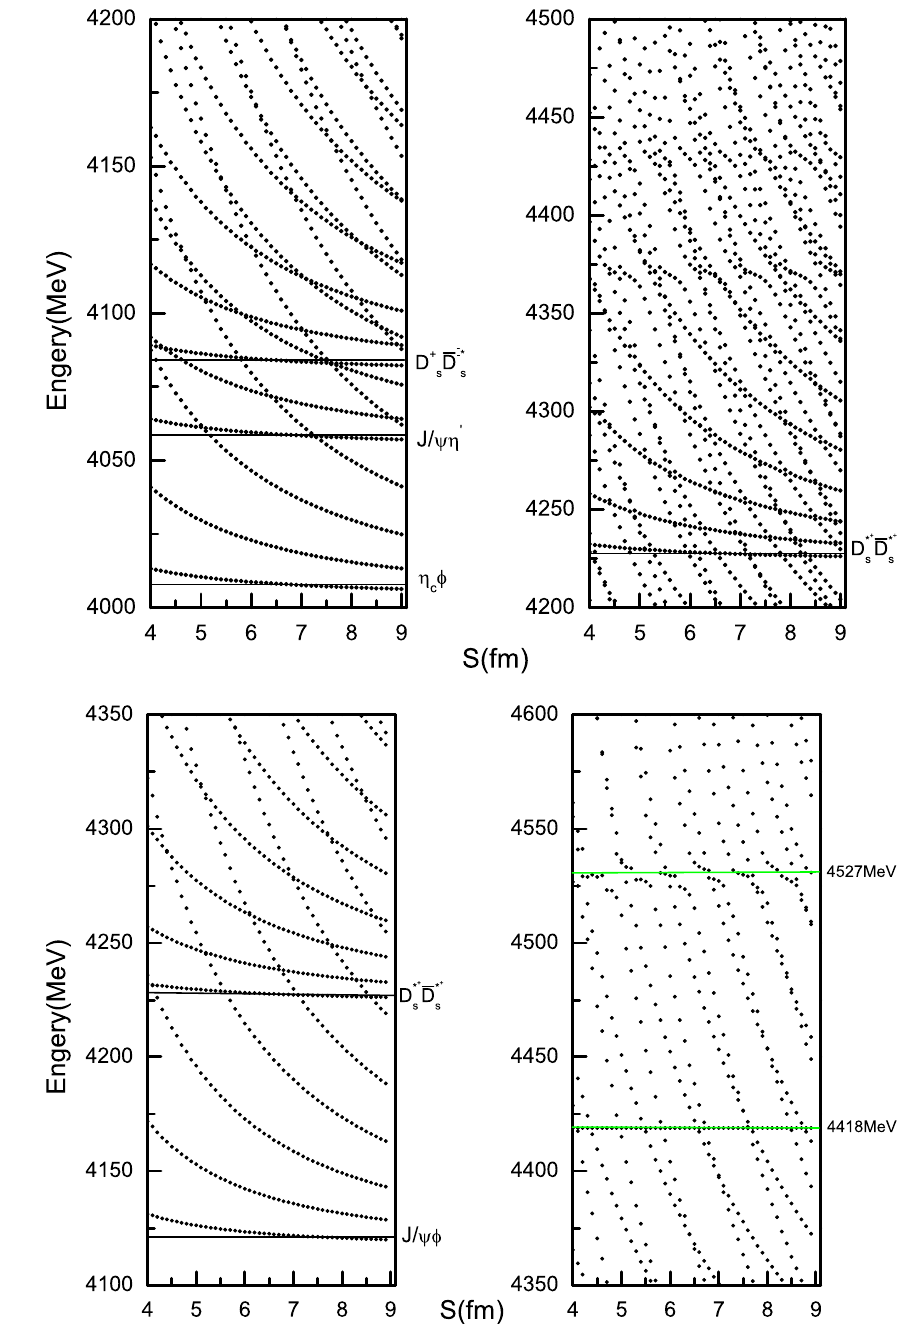
Fig. 5 The stabilization plots of the energies of the c ¯ cs ¯ s with J PC = 02 ++ in